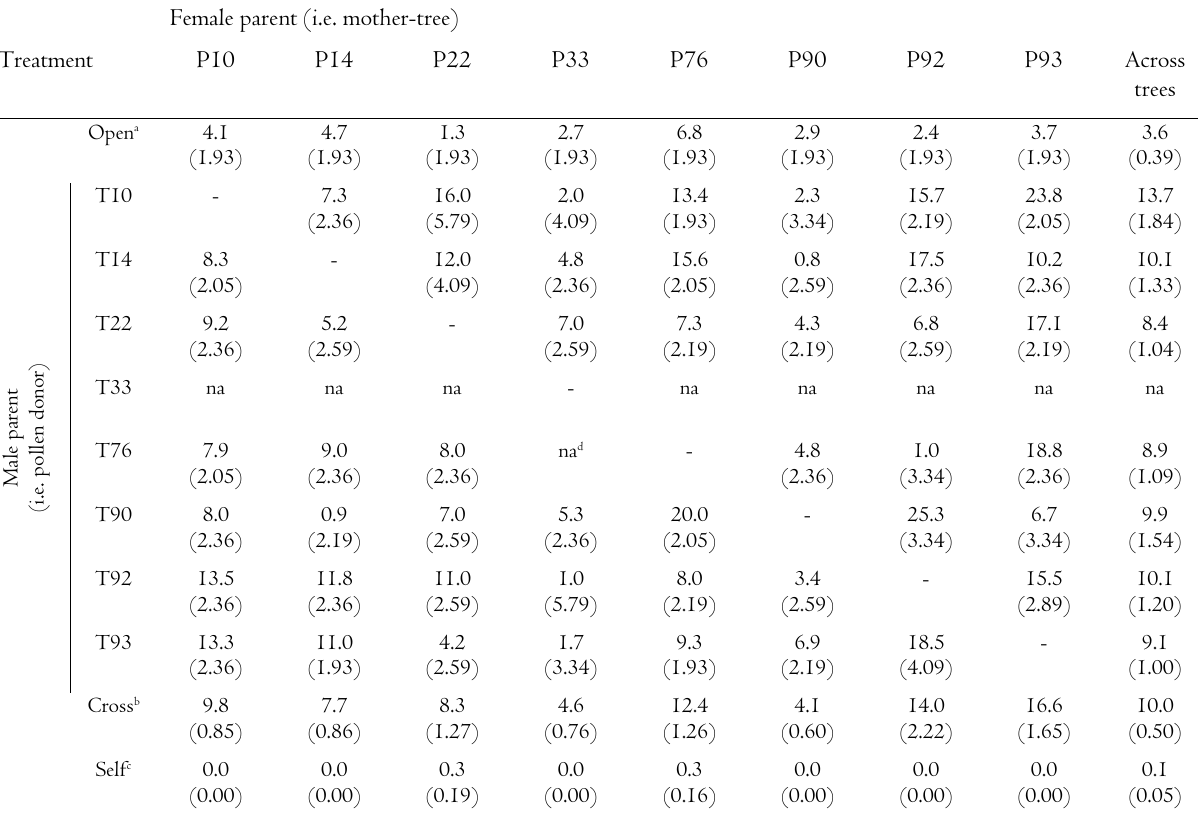
Table 2. Mean number (± SE) of mature pods per hermaphroditic capitulum (i.e. harvested pods) of Parkia biglobosa (incl. capitula without pods). Self-pollination (grey colour) is shown in the last row. Tree P33 was not used as a pollen donor. Female parent (i.e.